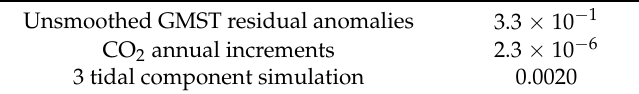
Table 9. Probability p statistics ( N = 38) in pair-wise regressions of UAH LT temperatures with oscillations from 1979 to 2016. The tidal data are derived from the simulation in Table 7.